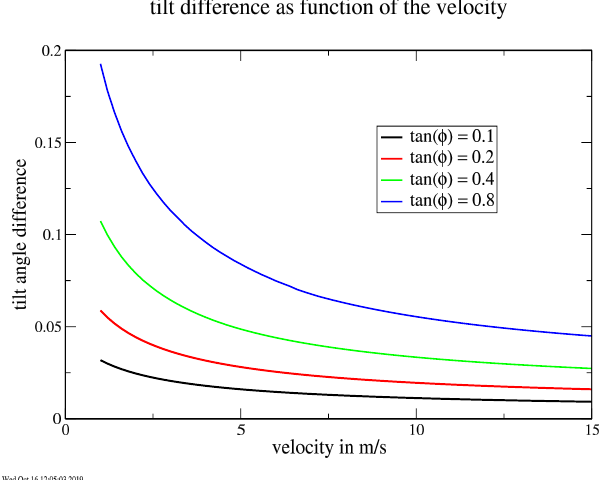
Figure 4: Difference φ − ψ as function of the